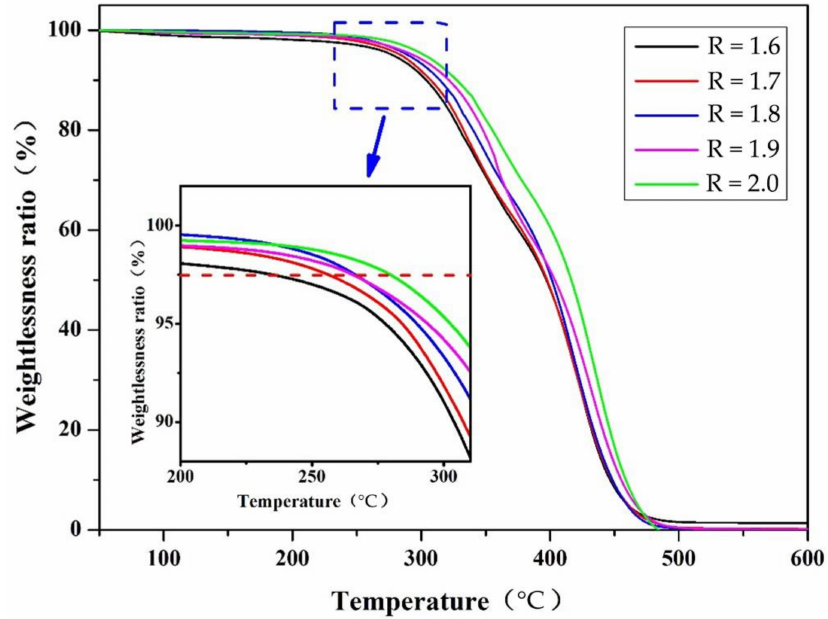
Figure 9. TGA curves of SPU films with different R